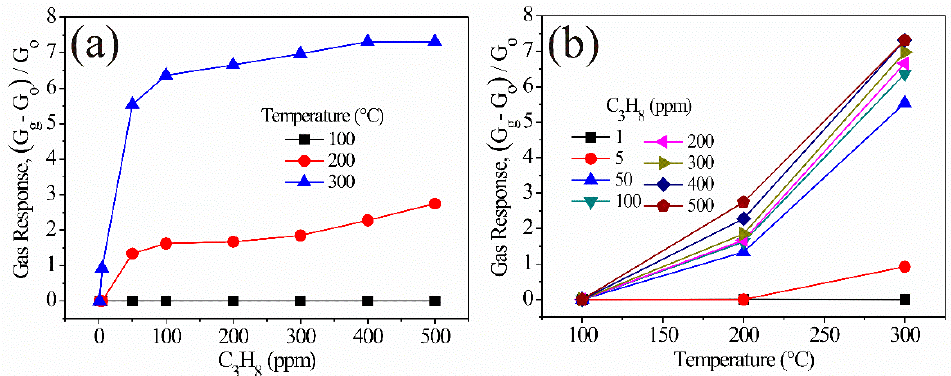
Figure 10. Response of ZnAl 2 O 4 pellets as a function of ( a ) propane concentration, ( b ) operating temperature.